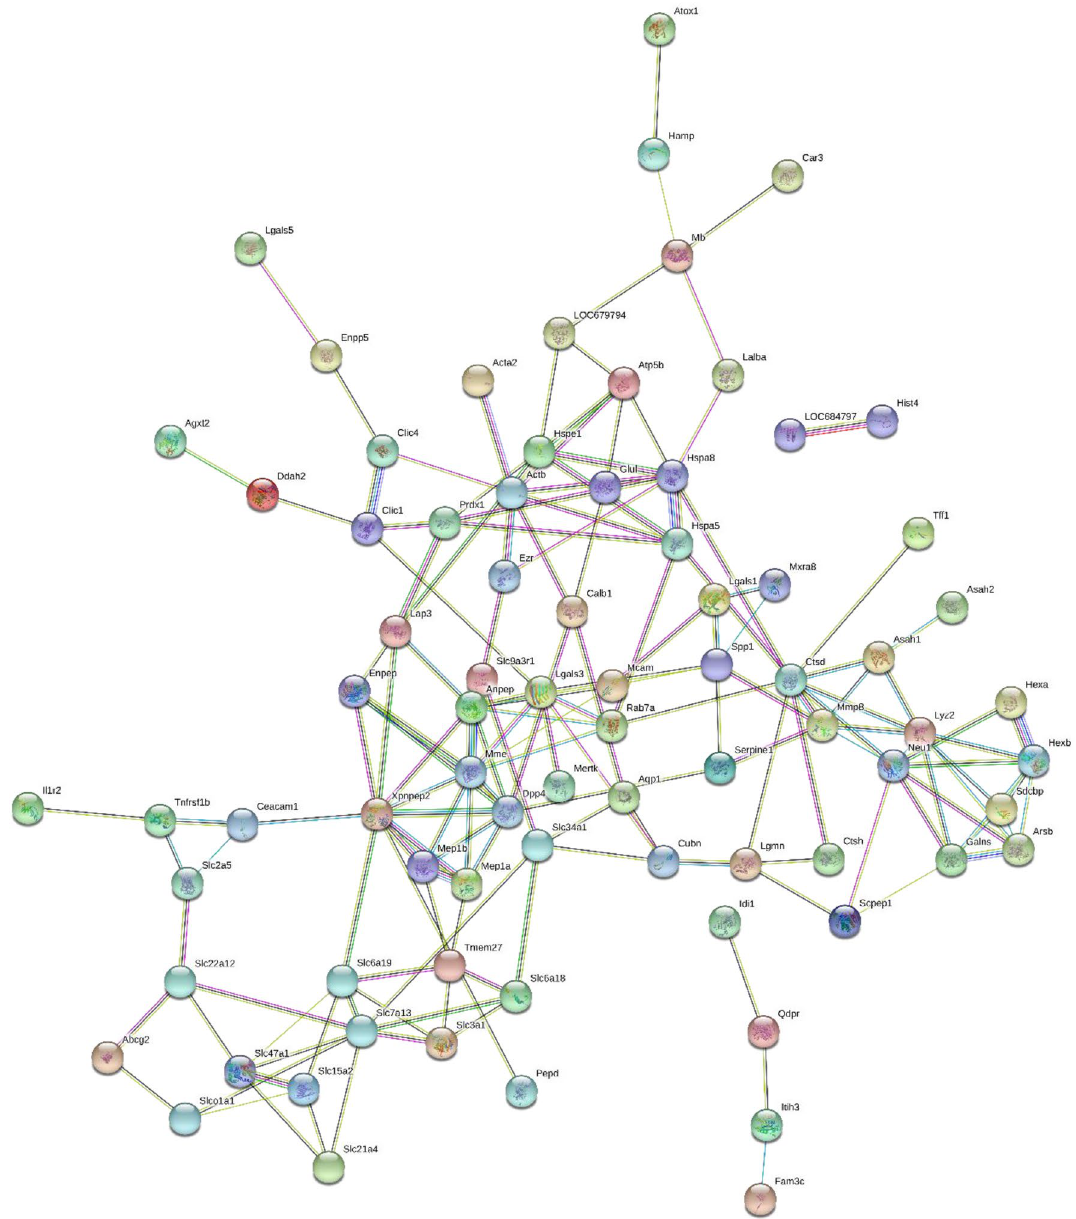
Figure 4. STRING PPI network analysis of the one hundred and ten differentially changed proteins in VILI rats. The average node degree is 2.78, the average local clustering coefficient is 0.354, and the PPI enrichment p-value is less than